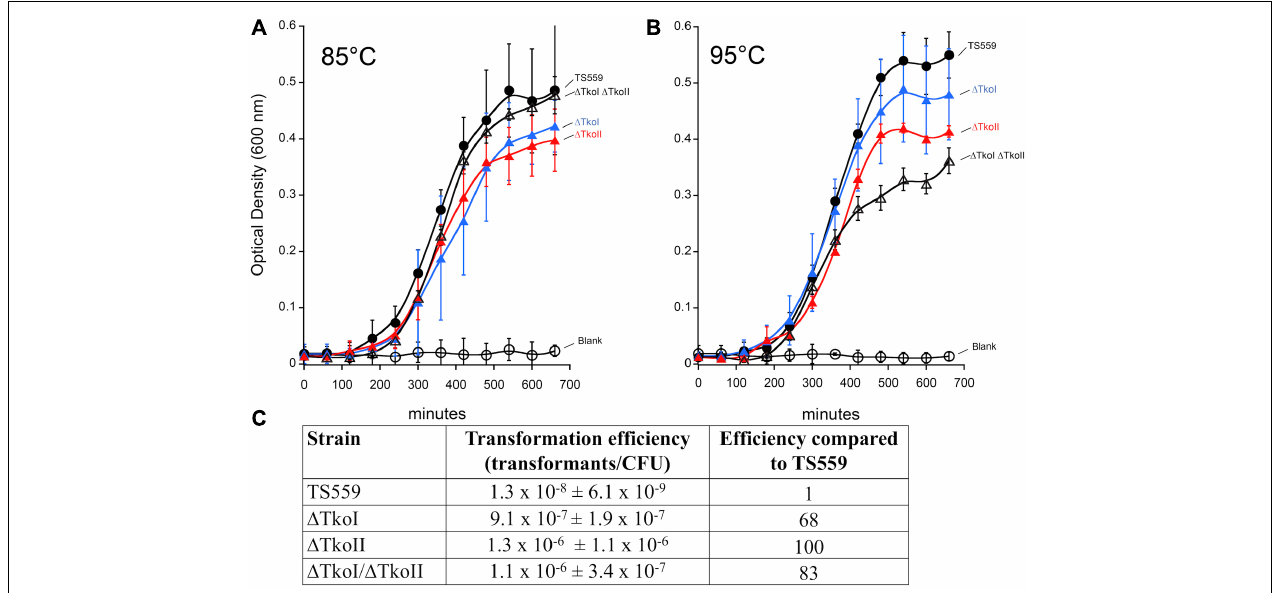
FIGURE 7 | Deletion of TkoI and TkoII impacts transformation efficiencies and growth rates. TS559 (closed circles) and strains (cid:49) TkoI (blue triangles), (cid:49) TkoII (red triangles) and (cid:49) TkoI/ (cid:49) TkoII (open triangles) were grown at either (A) 85 ◦ C optimal growth temperature or (B) at 95 ◦ C to induce heat stress. Optical density was monitored over time, n = ≥ 9. (C) TS559, (cid:49) TkoI, (cid:49) TkoII, and (cid:49) TkoI/ (cid:49) TkoII transformation efficiencies (transformants/CFU ± standard deviation) and efficiency compared to TS559 are